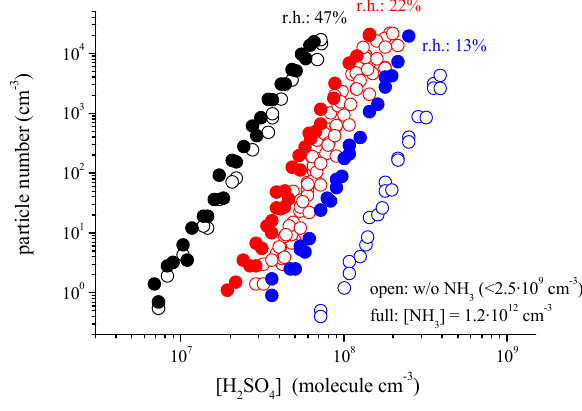
Fig. 1. Measured formation rate of 2-nm particles ( J 2 ) in differ- Figure 1. Measured formation rate of 2-nm particles ( J 2 ) in different atmospheric ent atmospheric locations (Hyyti¨al¨a, Melpitz and San Pietro Capofi- locations (Hyytiälä, Melpitz and San Pietro Capofiume) and in a laminar flow reactor ume) and in a laminar flow reactor (IfT-LFT) as a function of mea- (IfT-LFT) as a function of measured sulfuric acid concentration. sured sulfuric acid concentration.